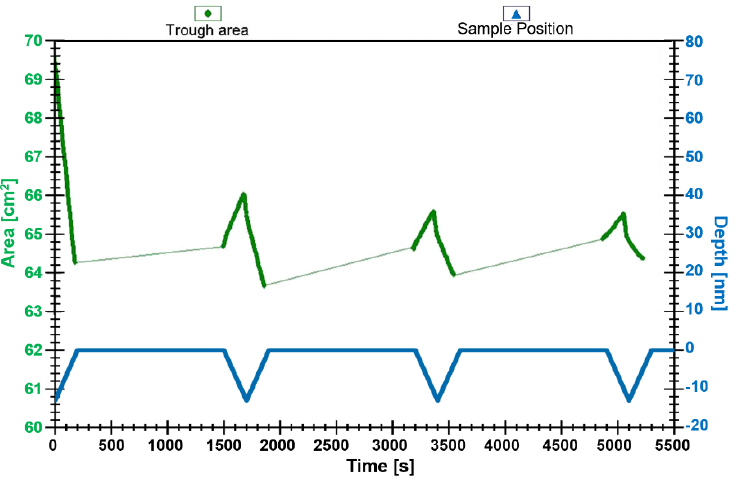
Figure 3. Plot of transfer ratio for attempted transfer and deposition of complex 3 onto a glass support at 4 mN m − 1 . Emersion and immersion are indicated by a solid line. The transferred layer was allowed to dry for 20 min after each emersion.